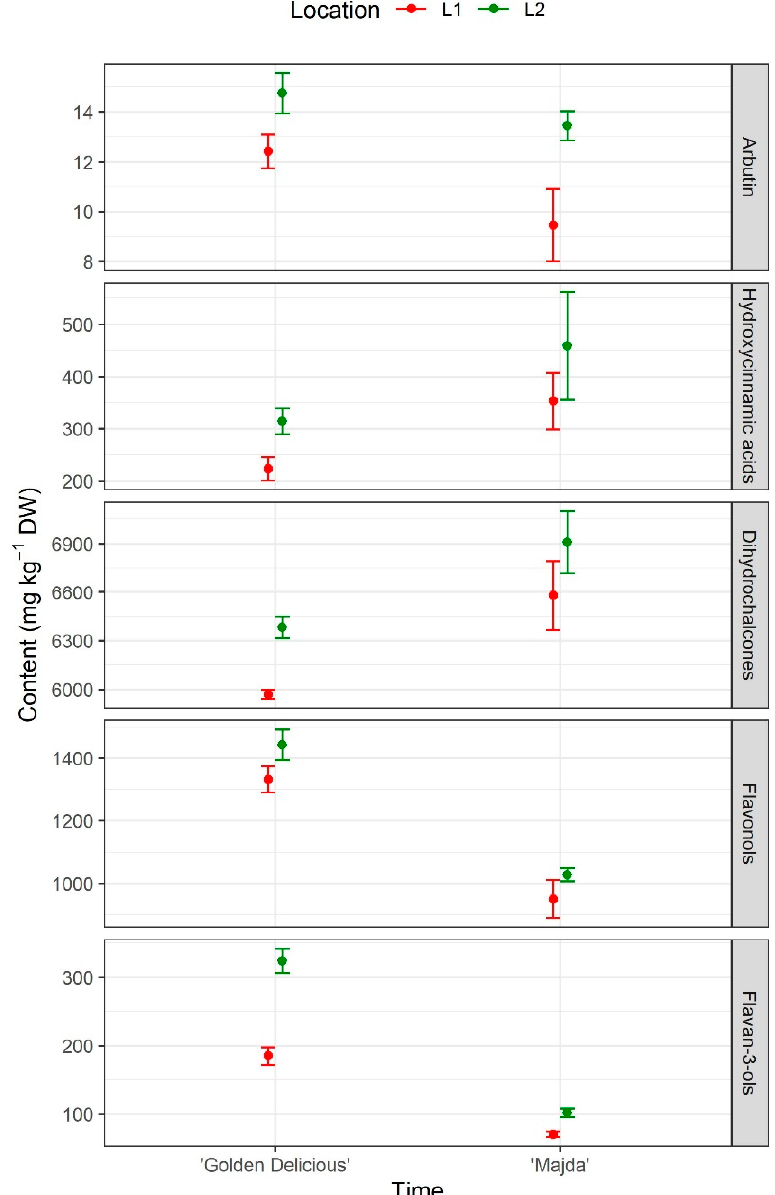
Figure 8. Phenolic content in apple leaves presented as arbutin and four groups: Hydroxycinnamic acids, dihydrochalcones, flavonols, and flavan-3-ols (mg kg − 1 DW) for cultivars ‘Golden Delicious’ and ‘Majda’ at two different locations (L1 and L2).